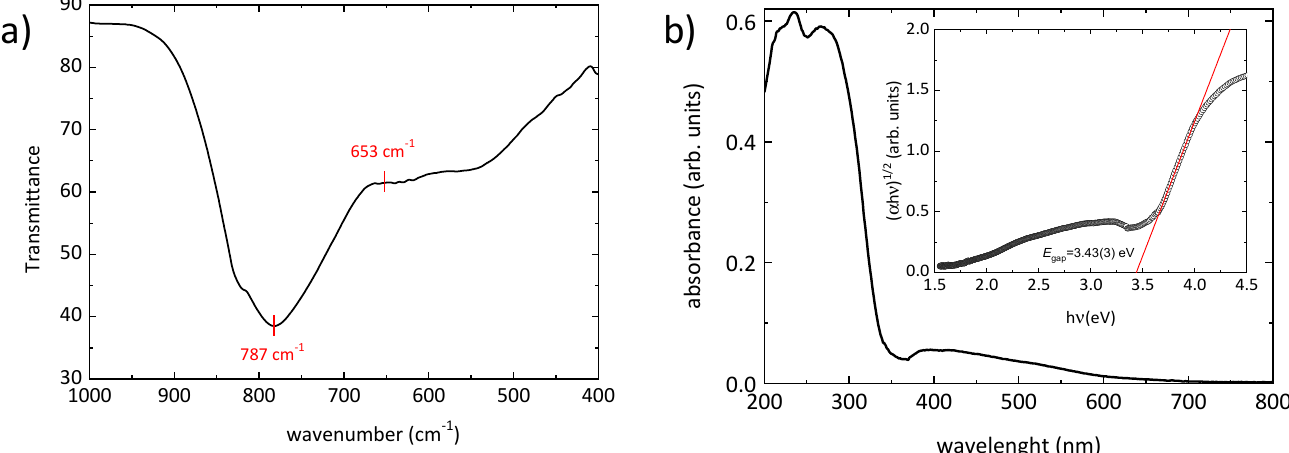
Figure 5. ( a ) FTIR transmission spectrum of nanocrystalline LiAl(IO 3 ) 4 in the 1000-400 cm − 1 range; ( b ) UV-Vis absorption spectrum. The inset in ( b ) shows the determination of the band gap E gap by means of a Tauc plot of the absorbance of LiAl(IO 3 ) 4 (indirect band gap).